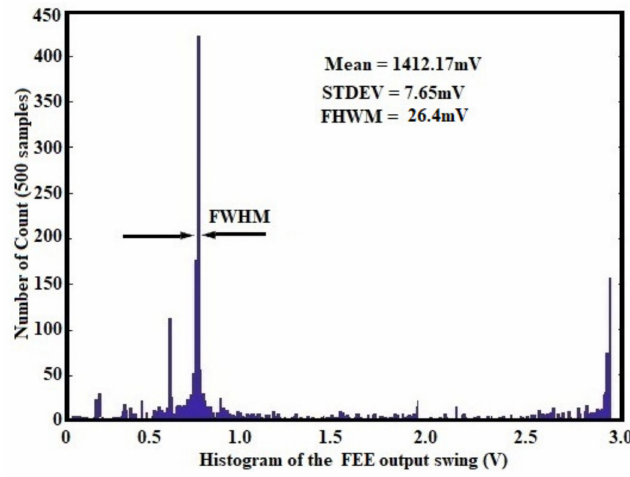
Figure 16. Histogram of output voltage for high charge production